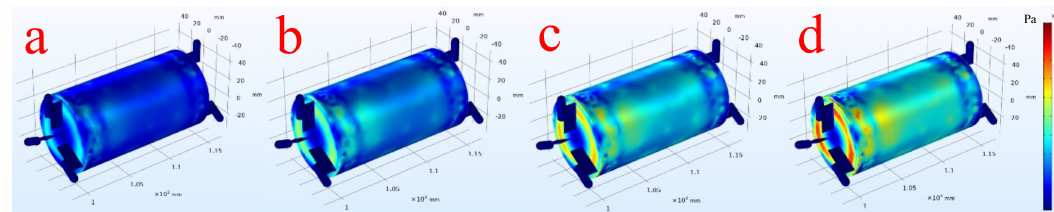
Figure 11. Wall shear stress distribution of the same piped carriage with di ff erent discharge ( D c × L c =